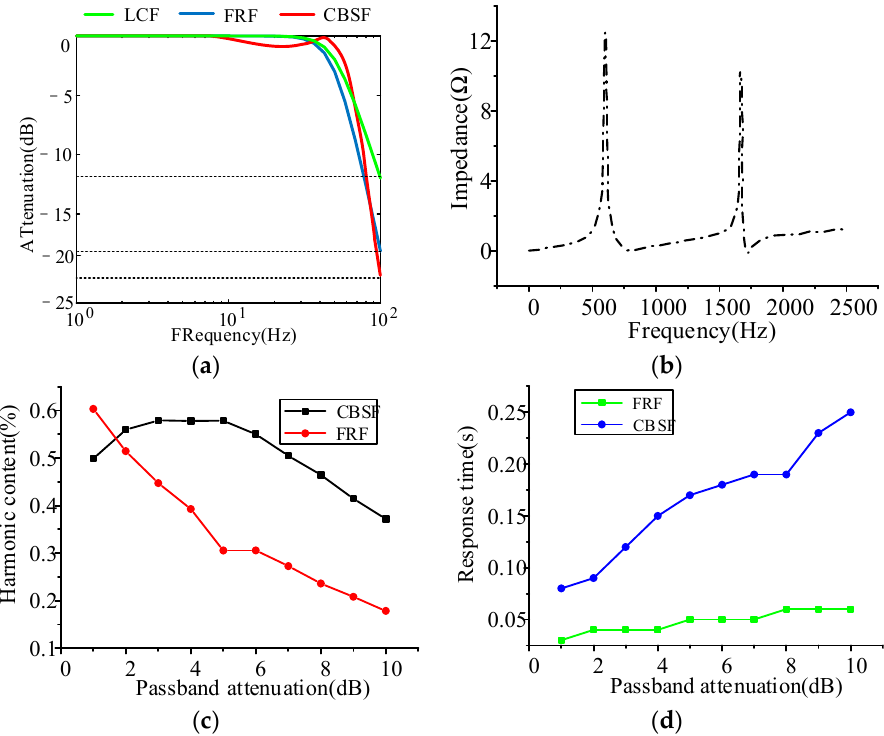
Figure 2. Comparison of different passive filters: ( a ) LCF, FRF, CBSF; ( b ) TF; ( c ) Harmonic content for FRF and CBSF, and ( d ) Response time for FRF and CBSF.